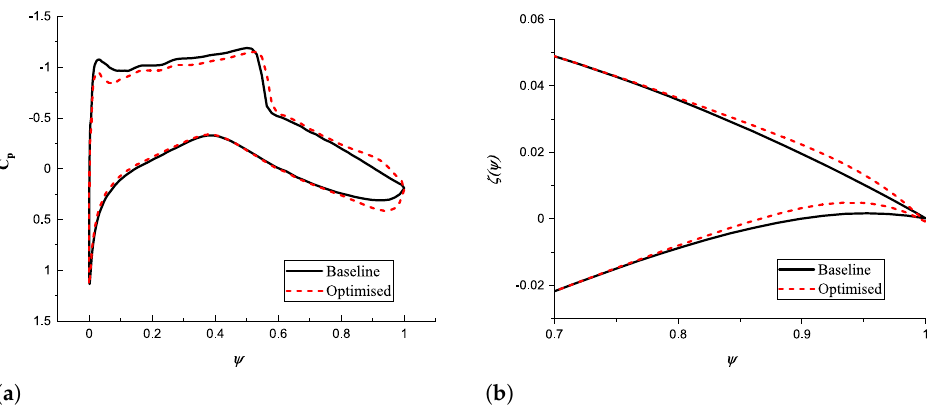
Figure 10. Comparison of results for the RAE 2822 optimization using a morphing trailing edge. ( a ) C p distribution. ( b ) Airfoil